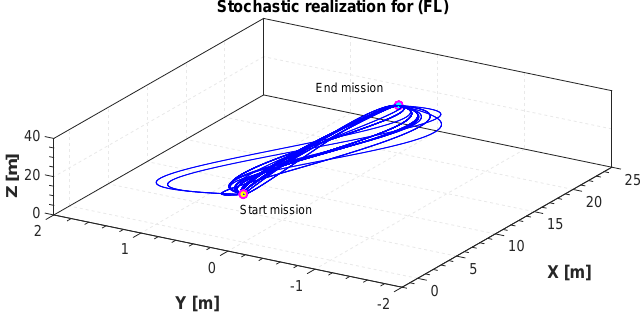
Figure 5. Stochastic realization for flight level (FL).